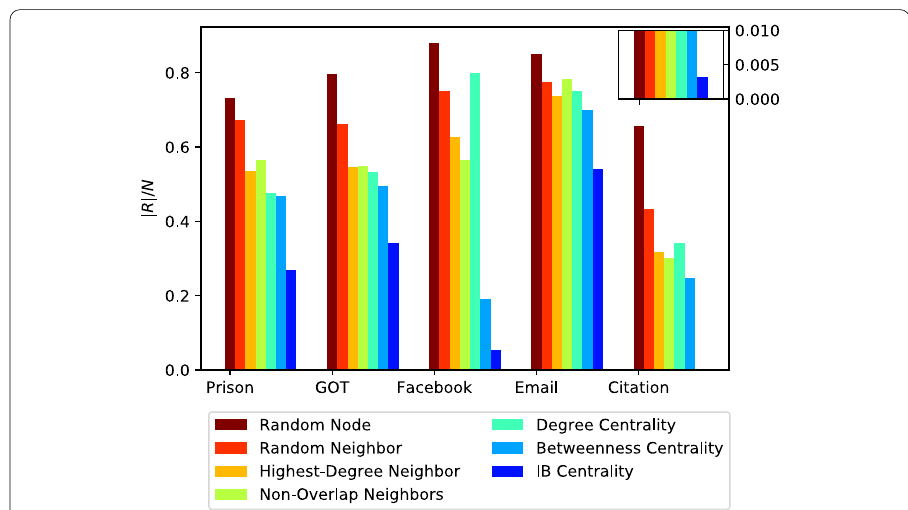
Fig. 4 Average ratio of infected nodes after convergence | R |/ N as a function of the network topology G . The inset on the top right corner provides a zoomed-in view of the Citation network topology. IB Centrality (blue bars) considerably outperforms all other benchmark